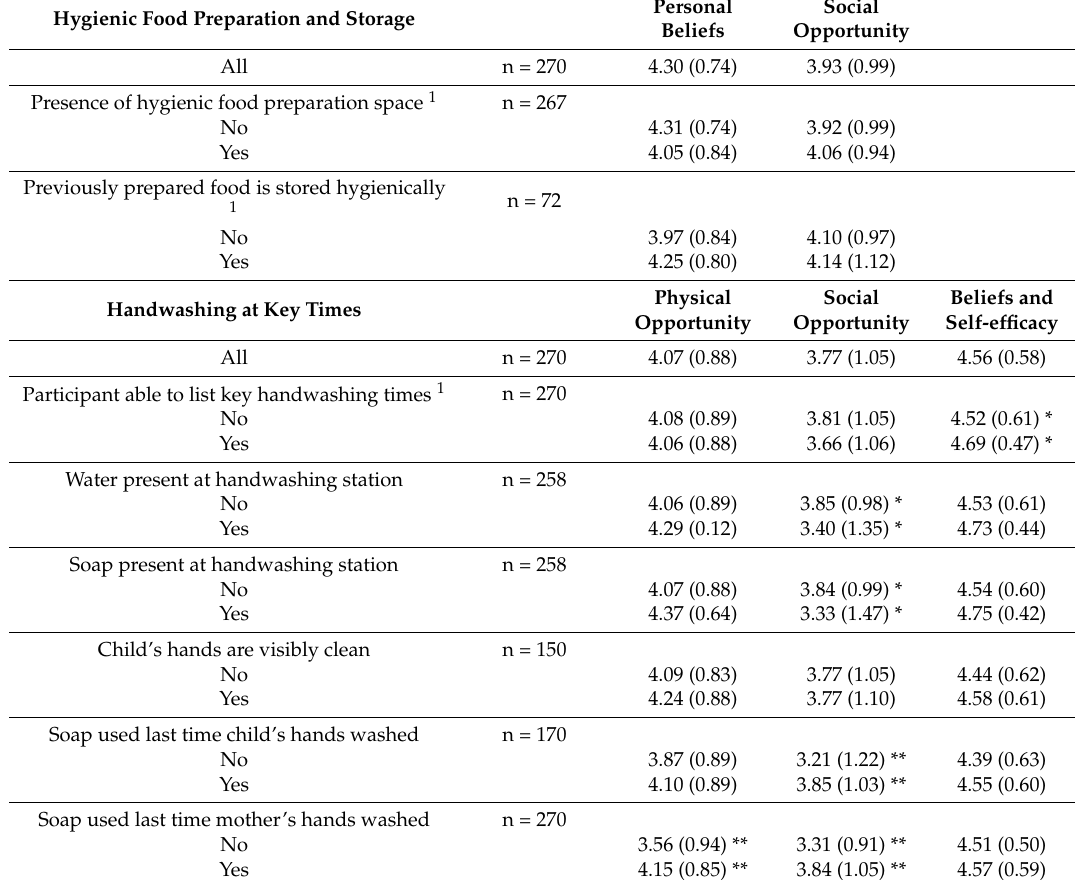
Table 5. Hygiene behavior measure scores by key outcomes. Numbers are mean score